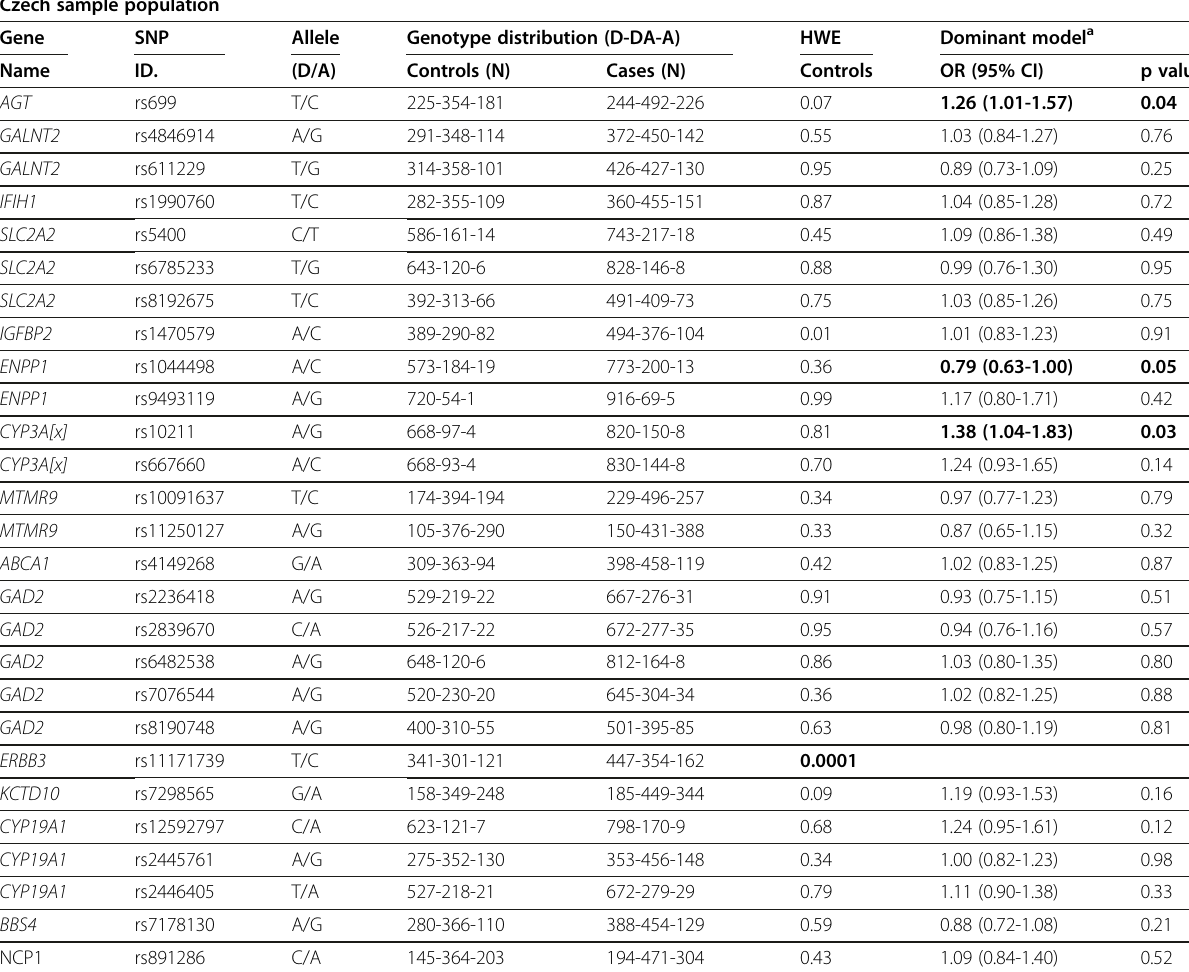
Table 3 Genotype distribution of the polymorphisms in the Czech population Czech sample